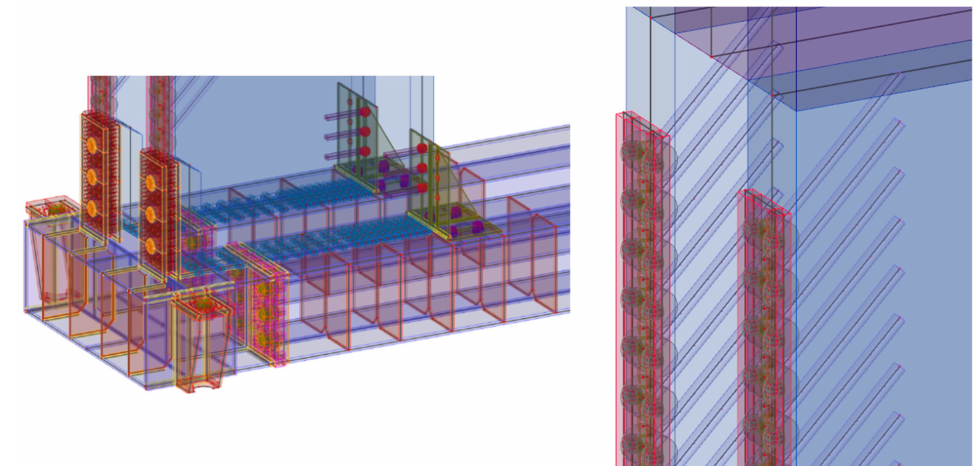
Figure 8. Computational model—detail of the mesh of finite elements of the frame.